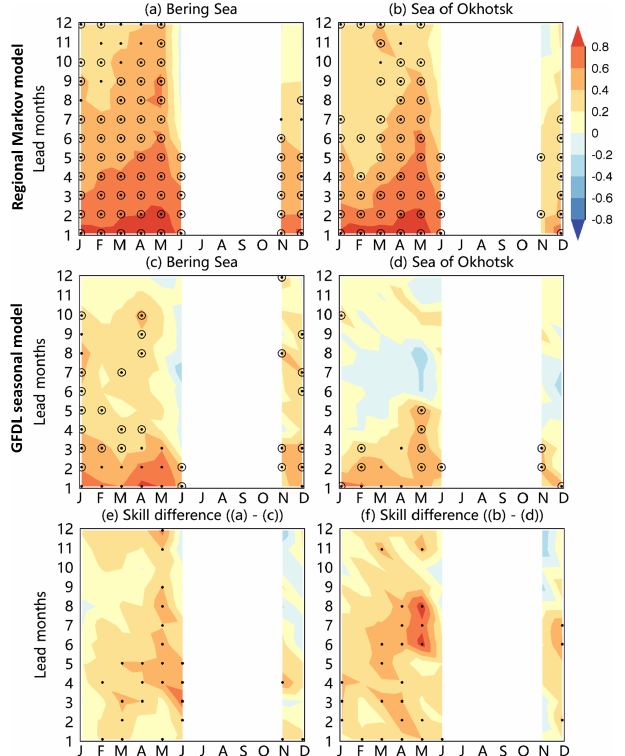
Figure 11. (a, b) Hindcast model skill (ACC) for detrended regional SIE forecasts from 1982 to 2020 for the regional Markov model. (c, d) Same as (a, b) except for the GFDL seasonal prediction sys- tem. Panels (e, f) show the skill difference between these two mod- els. The black dots in (a) – (d) represent ACCs that are significantly above the 95% confidence level, and the circles in (a) – (d) indi- cate months in which the model’s skill exceeds that of a persistence forecast. The black dots in (e) – (f) represent ACC differences that are significant above the 95% confidence level.